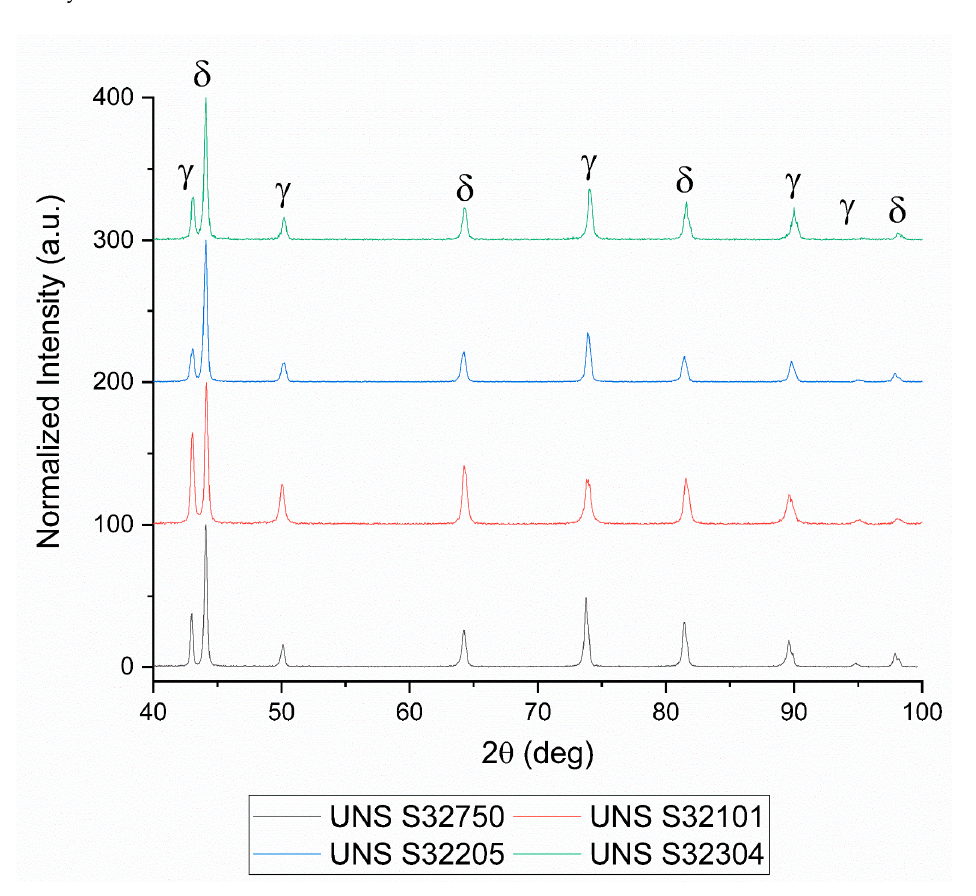
Figure 3. X-ray di ff raction patterns of the tested material. Figure 3. X-ray diffraction patterns of the tested material.